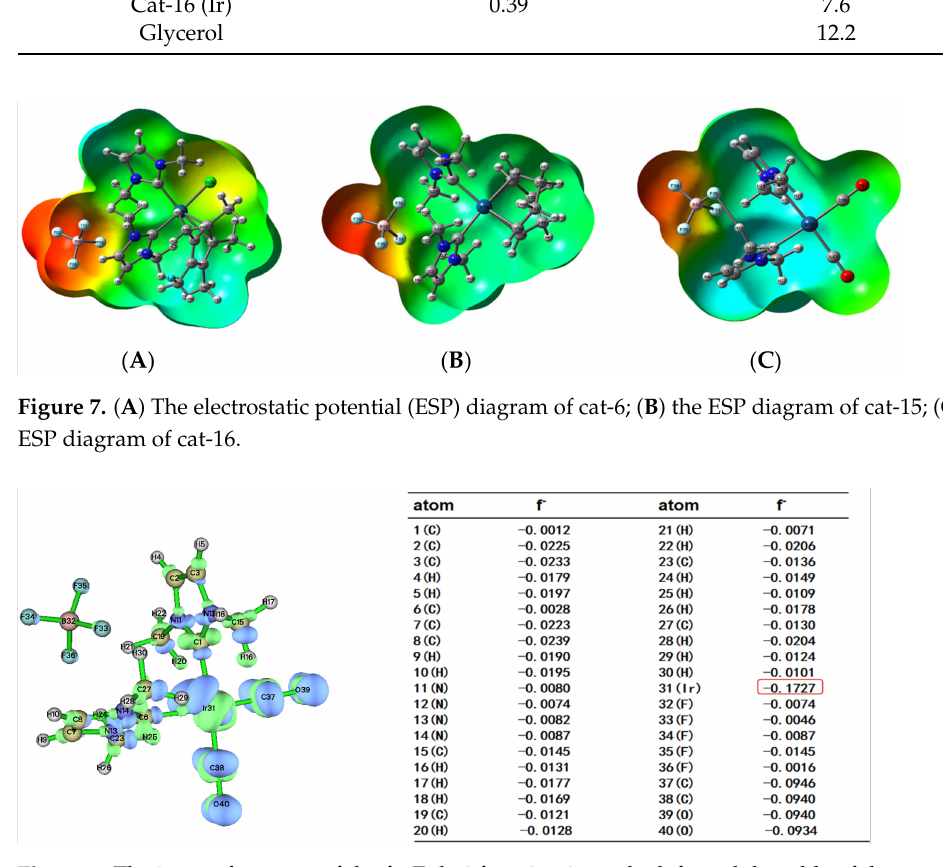
Figure 8. The iso-surface map of the f − Fukui function is on the left, and the table of the numerical value of f − of all atoms is on the right. The maximum value is within the red